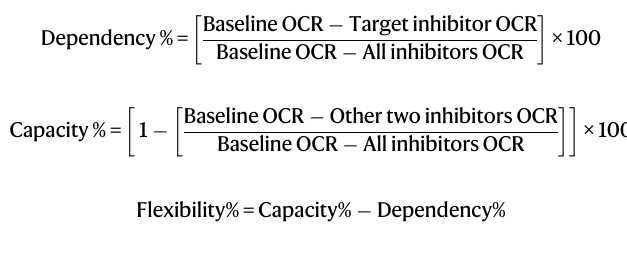
Fig. 7 | Protein interactionnetwork analysis links PFKFB2/3to the RAS-ERK1/2 pathway. a Spectral counts) of the identi fi ed proteins in the PFKFB2 protein complexes upon the indicated treatments in NRAS Q61 - and BRAF V600E -mutant mela- noma cells ( n =3 biologically independent experiments). Proteins already descri- bed to interact with PFKFB2 (black); new proteins described in this work (blue). b Representativeimmunoblotshowingthe amountsof theindicatedproteinsafter isolation of His-tagged PFKFB2 complexes in NRAS Q61 and BRAF V600E mutant mela- noma cells. Numbers show the fold induction of the indicated ratio ( n =3 biologi- callyindependentexperiments). c Graphsshowingthefoldchangedifferenceswith respect to the control (spectral peak areas) of the indicated phosphorylated/ unphosphorylated ratio peptides in NRAS Q61 and BRAF V600E mutant melanoma cells upon the indicated treatments. Each condition represents three biologically inde- pendent experiments ( n =3) that were pooled before the mass spectrometry ana- lysis. d Immunoblot showing the binding of PFKFB2 to BRAF and p-BRAF S445 in NRAS Q61 mutant melanoma cells under 1hGS; n =3 independent experiments per treatment). e Representative in vitro interaction assay of GST-BRAF and recombi- nant PFKFB2(rPFKFB2).Immunoblots show the amounts of the identi fi edproteins after GST pull-down ( n =3 independent samples). GST protein was used as